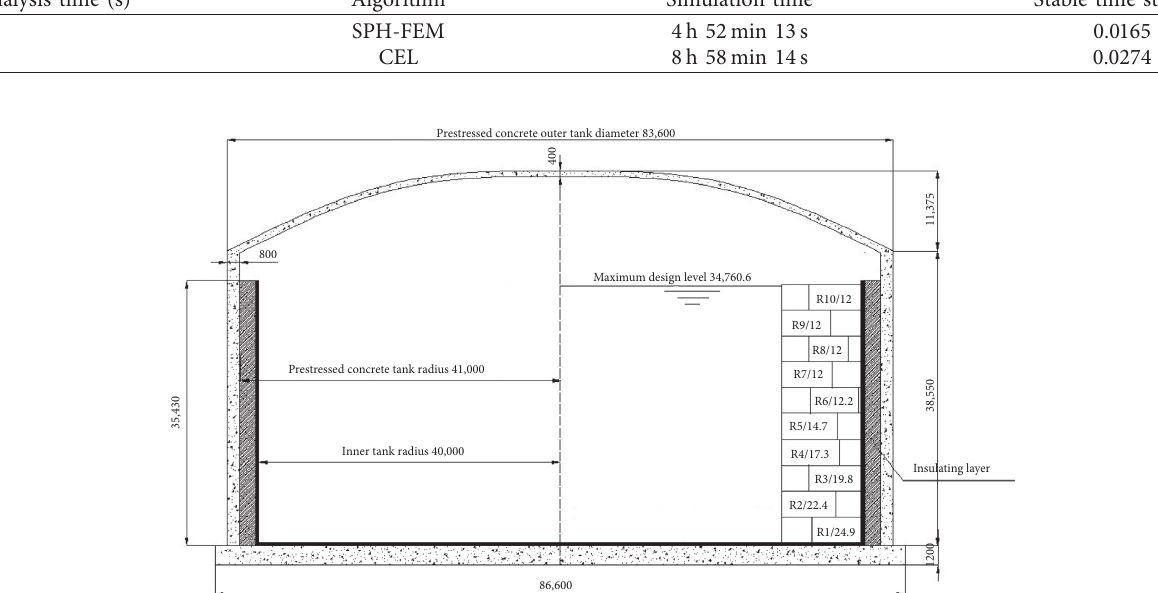
Table 2: Comparison of the computational efficiencies of the two algorithms. Analysis time (s)